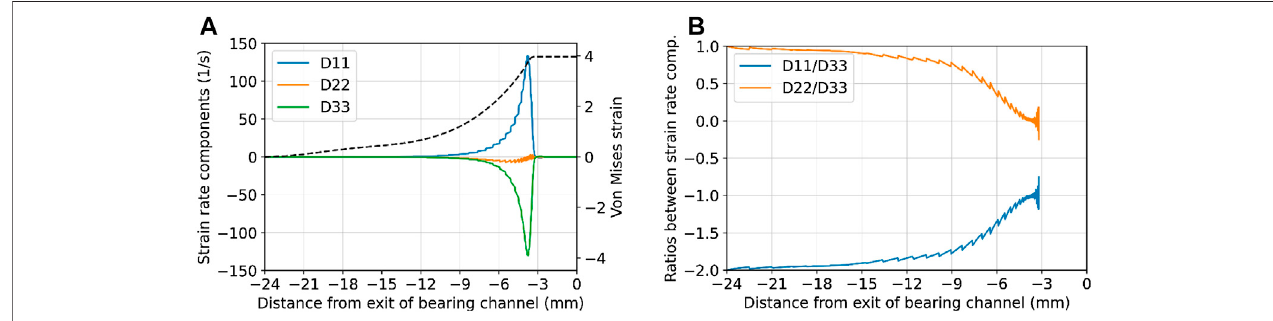
FIGURE 2 | Deformationmodeanalysisforthecenterdeformationpath; (A) plotofcomponentsofthedeformation ratetensor; (B) ratiosbetweenthesecomponents.